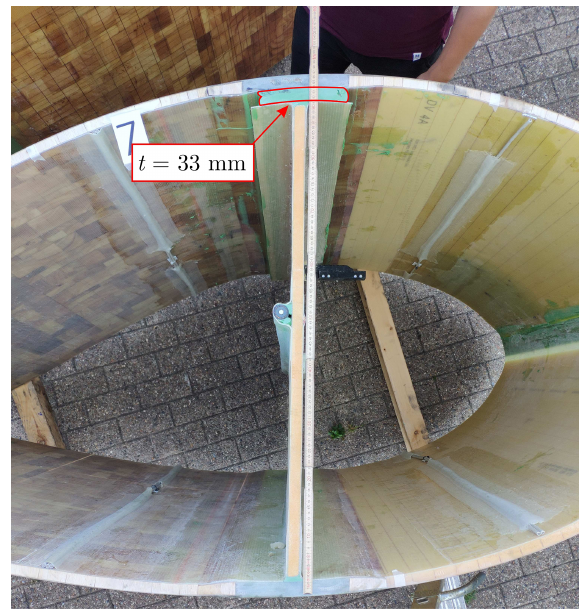
Figure 5. Cut cross section at a radial position of 5.2m ( r 26% ) with an erroneous manufactured shear web/spar cap adhesive joint on the pressure side of the blade. The width should cover the complete web flange, and the designed thickness is 9 ± 3mm; however, the real thickness is measured to be 33mm.